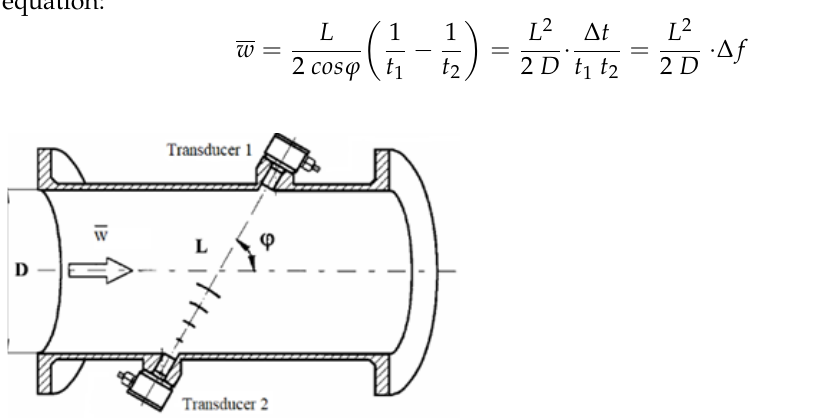
Figure 1. Measurement principle of the ultrasonic gas meters.